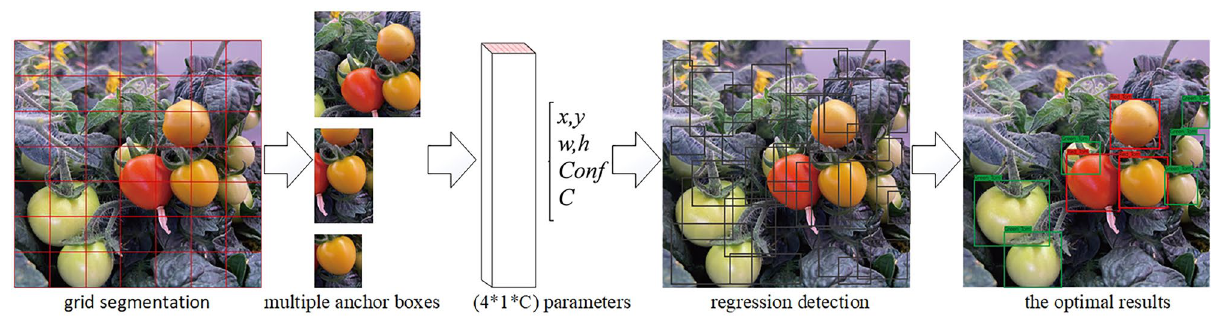
Figure 4. Principle of YOLO target recognition